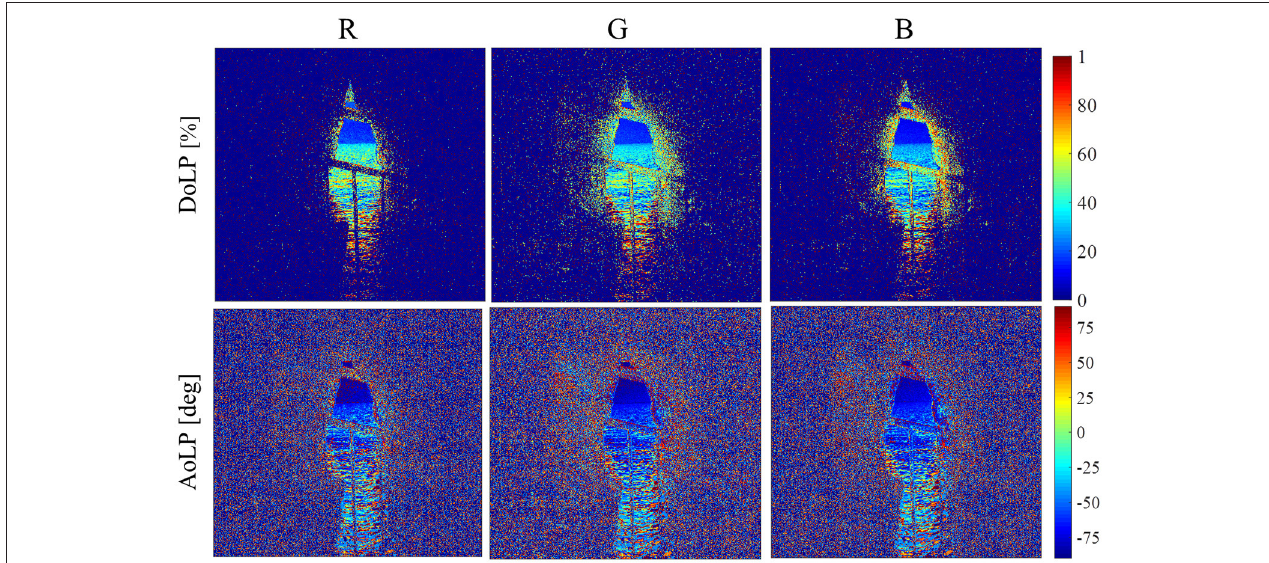
FIGURE 7 | DoLP and AoLP photos from 10:00 local time on February 14th, 2016, for the red (R), green (G), and blue (B) color bands, as obtained with short exposure time.